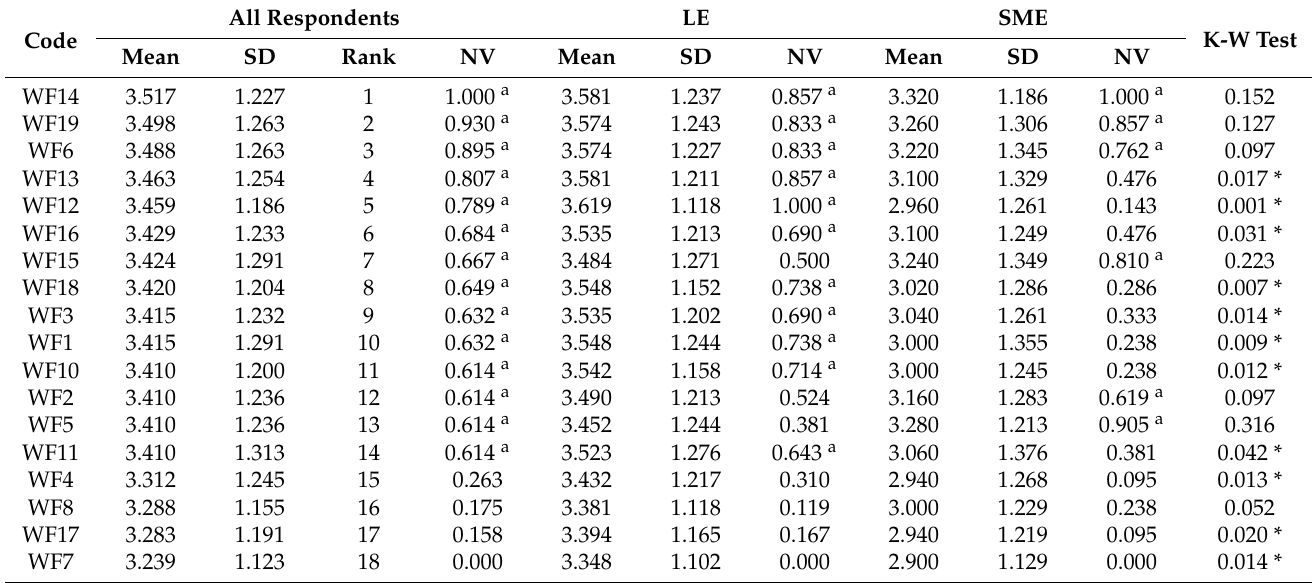
Table 3. Results of mean ranking analysis and Kruskal–Wallis test according to organization